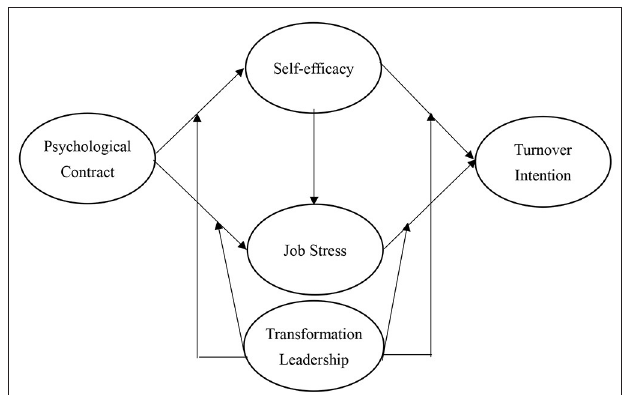
FIGURE 1 | Research